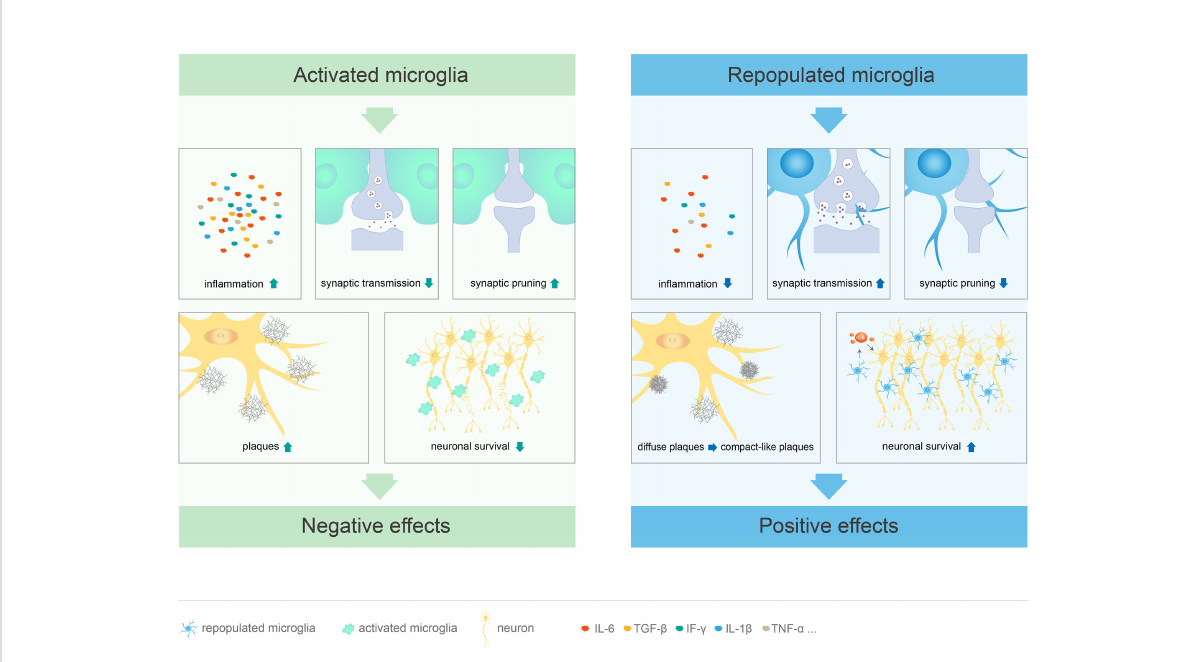
FIGURE 2 Different functions of activated and repopulated microglia in CNS diseases. Microglial activation leads to cognitive de fi cits through excessive synaptic pruning and inhibition of synaptic transmission. At the same time, these cells promote the release of in fl ammatory factors, stimulate plaque formation, and directly damage neurons, which leads to CNS diseases. Repopulated microglia not only suppress the in fl ammatory response, but also limit neuritic dystrophy by promoting the transition from diffuse to compact-like plaques. These cells can restore cognitive function by promoting synaptic transmission and inhibiting excessive synaptic pruning. Furthermore, repopulated microglia mediate neuroprotective effects by inducing IL-6 within